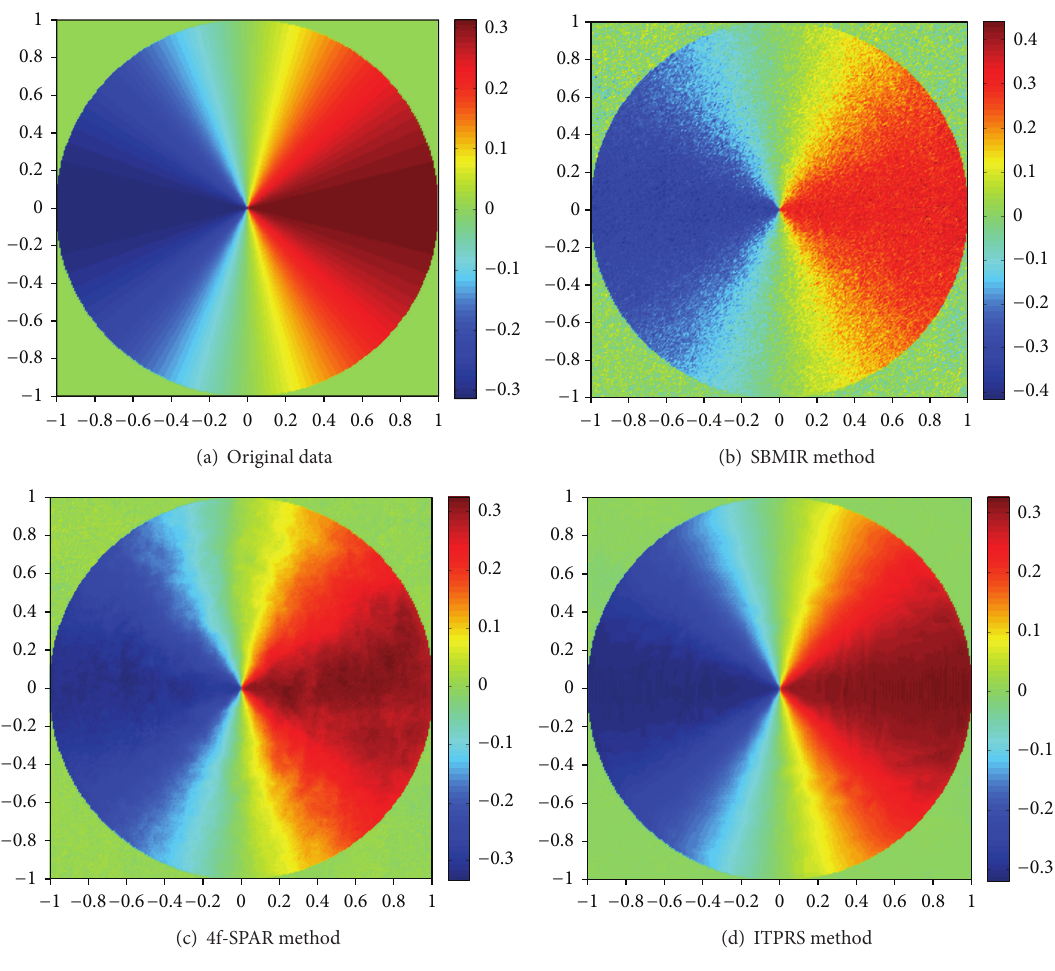
Figure 5: Color results of the reconstructed surface.